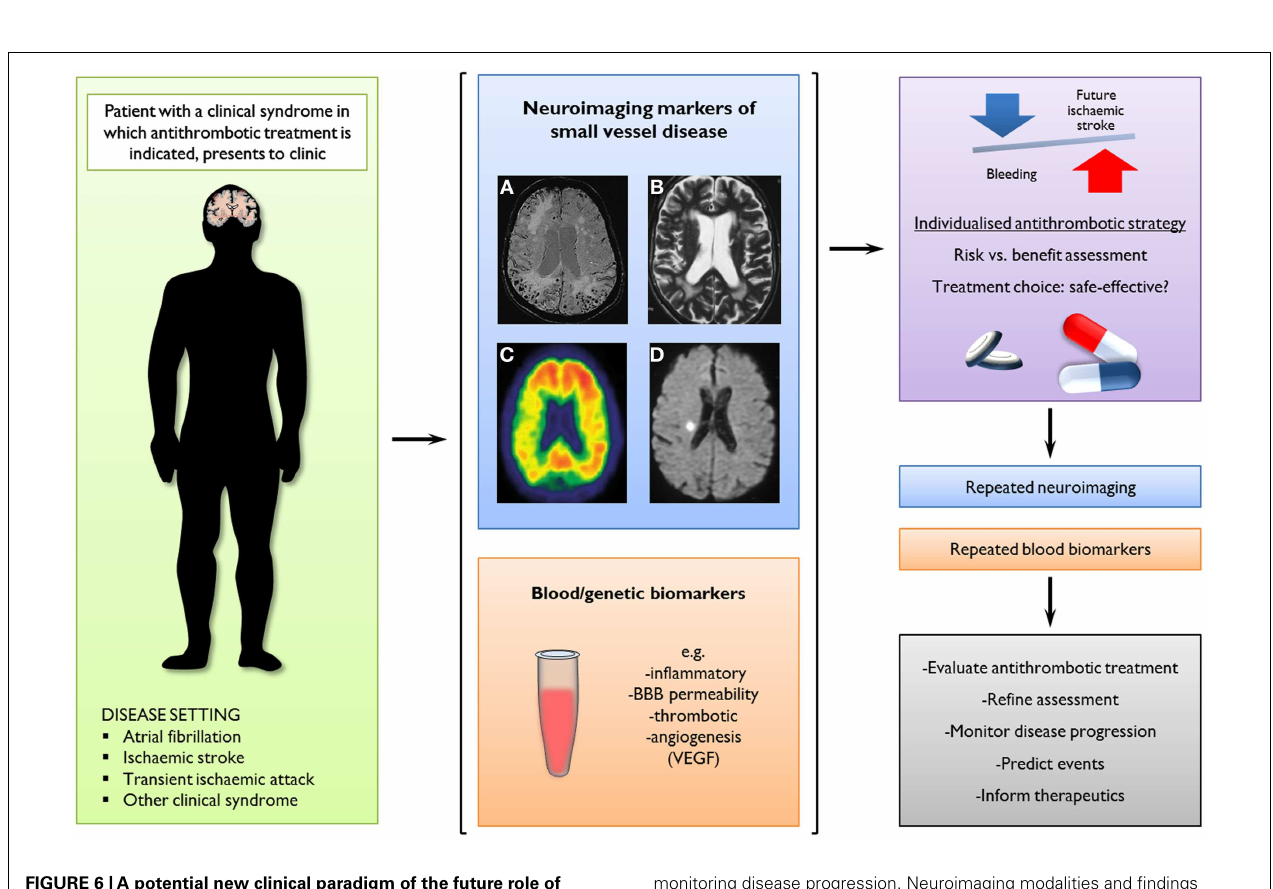
FIGURE 6 |A potential new clinical paradigm of the future role of neuroimaging markers of small vessel disease and blood/genetic biomarkers to predict intracerebral hemorrhage (ICH) by guiding stratified antithrombotic treatment decisions. In this scenario, a combination of imaging markers could be used to assess the relative balance of risk for future ischemic stroke or ICH, informing therapeutic decisions as well as potentially evaluating treatment effects and